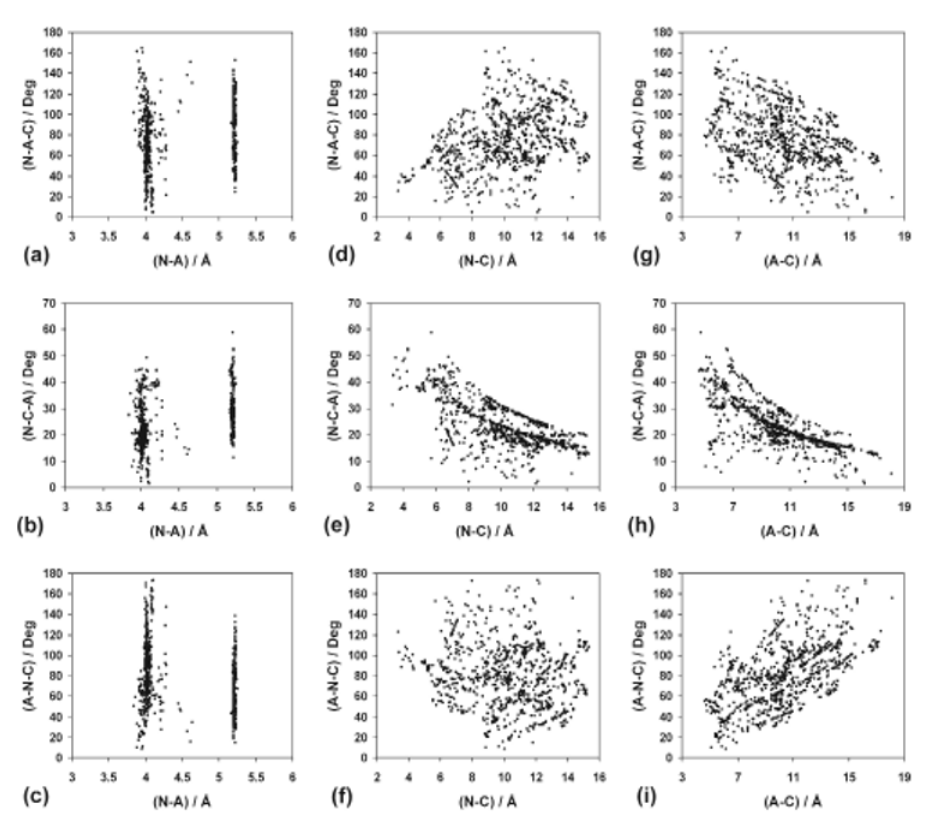
Figure 5. Nine different types of distance-angle maps, regarding the second subgroup of pharmacophore elements, for the S[3] stereoisomer: ( a ) the ( N-A ) – ( N-A-C ), ( b ) the ( N-A ) – ( N-C-A ), ( c ) the ( N-A ) – ( A-N-C ), ( d ) the ( N-C ) – ( N-A-C ), ( e ) the ( N-C ) – ( N-C-A